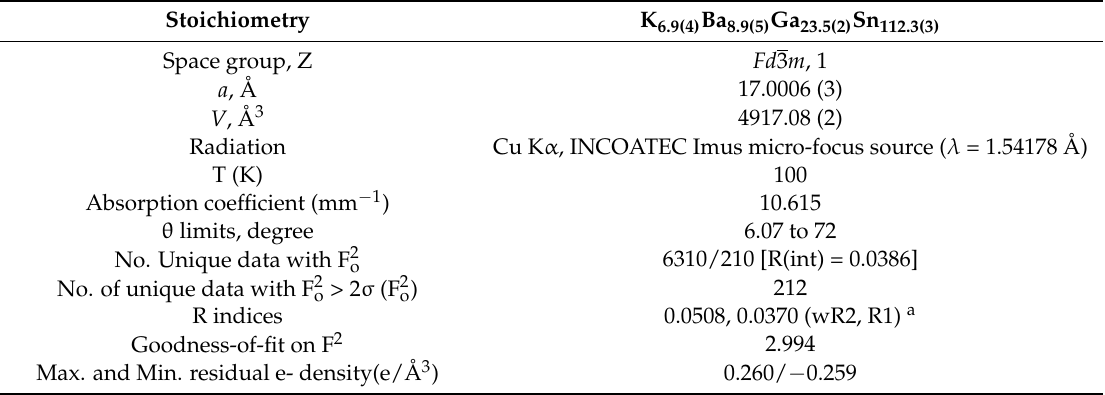
( b ) K 7.1(2) Ba 8.8(3) Ga 25.1(4) Sn 110.8(3) , including profile fit, profile difference, profile residuals, and Bragg